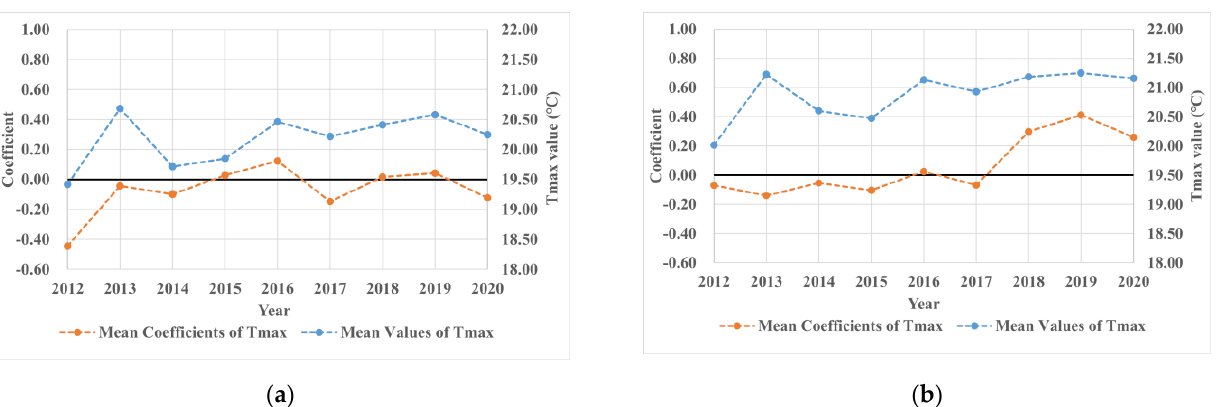
Figure 17. Temporal trends of mean Tmax values and mean Tmax coefficients in ( a ) Lu’an ; ( b ) Chi- zhou.